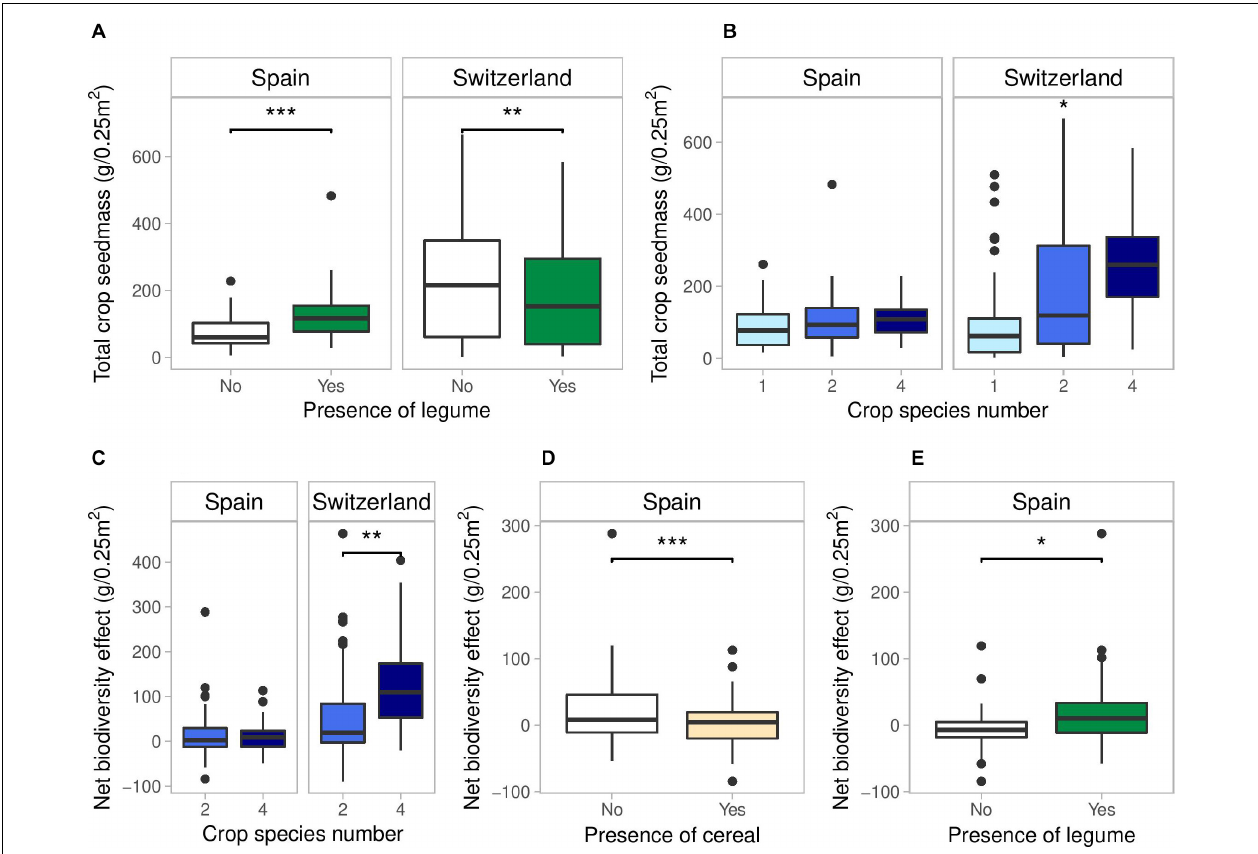
FIGURE 2 | Effects of legume presence and crop species number on total crop yield (A,B) , and effects of crop species number, presence of cereal and legume on Net biodiversity Effects (C–E) in Spain and Switzerland. Horizontal lines represent the median of the data, boxes represent the lower and upper quartiles (25 and 75%), with vertical lines extending from the hinge of the box to the smallest and largest values, no further than 1.5 × the interquartile range. Data beyond the end of the whiskers are outlying and plotted individually. See Tables S5, S6, S7 and S8 for the results of the statistical analyses. * p < 0.05, ** p < 0.01, and *** p <